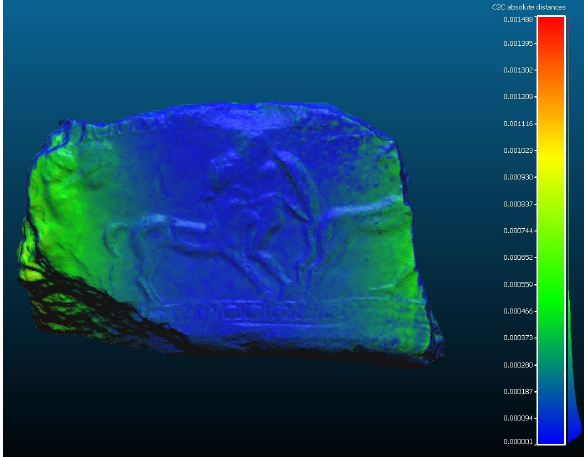
Figure 10. Cloud-to-cloud distance between dense point clouds of the fragment with Centauromachia scene.